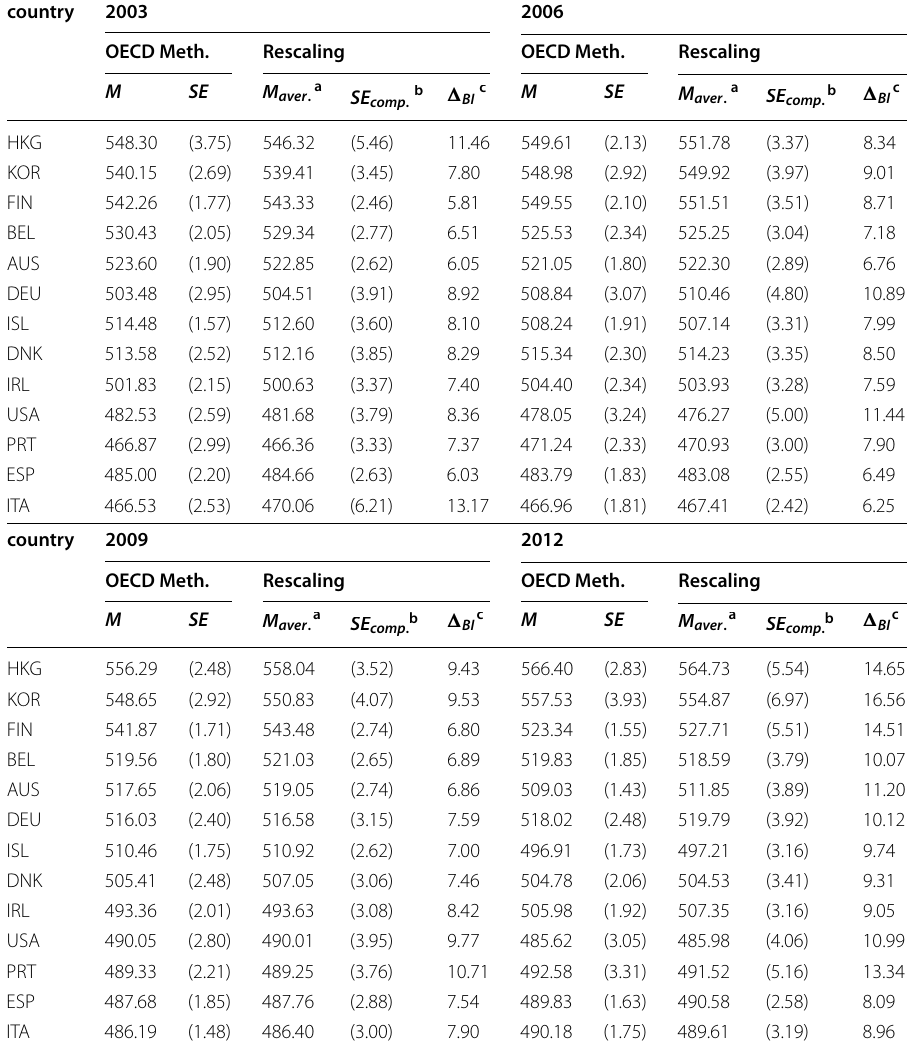
Table 2 Comparison of Country Means Standard Errors and Confidence Intervals for OECD Method and Rescaling for 13